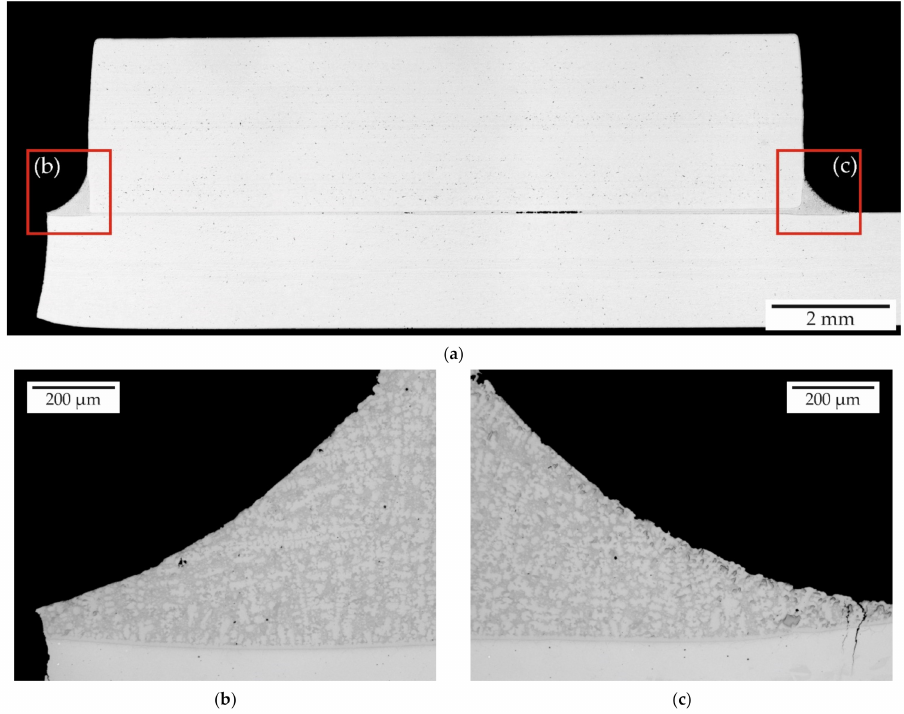
Figure 10. Cross-section of the brazed joint of a failed specimen: ( a ) overview; ( b ) filler metal seam where the failure occurred; ( c ) filler metal seam featuring crack propagation into the base